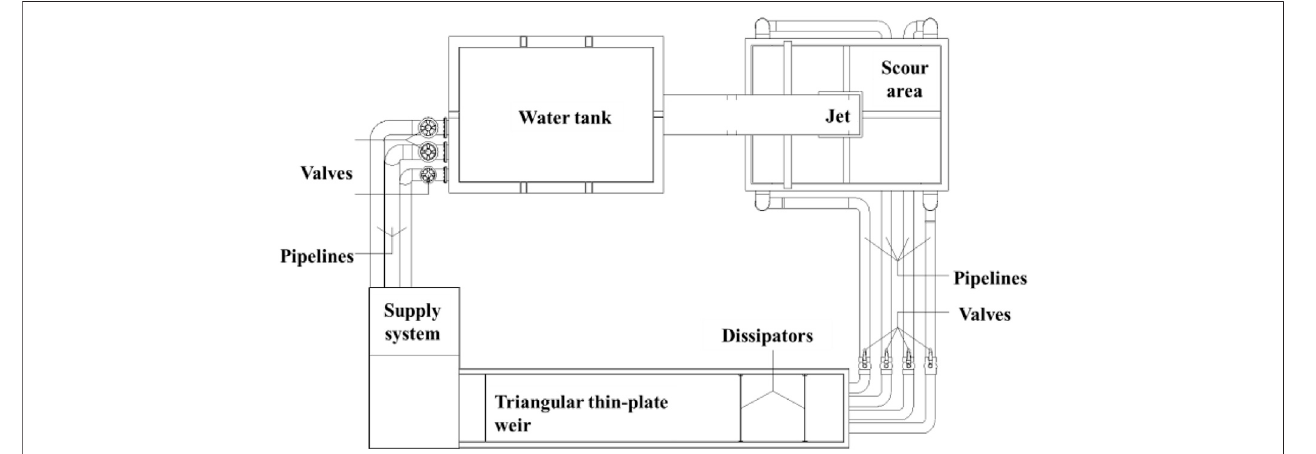
FIGURE 2 | Experimental apparatus.